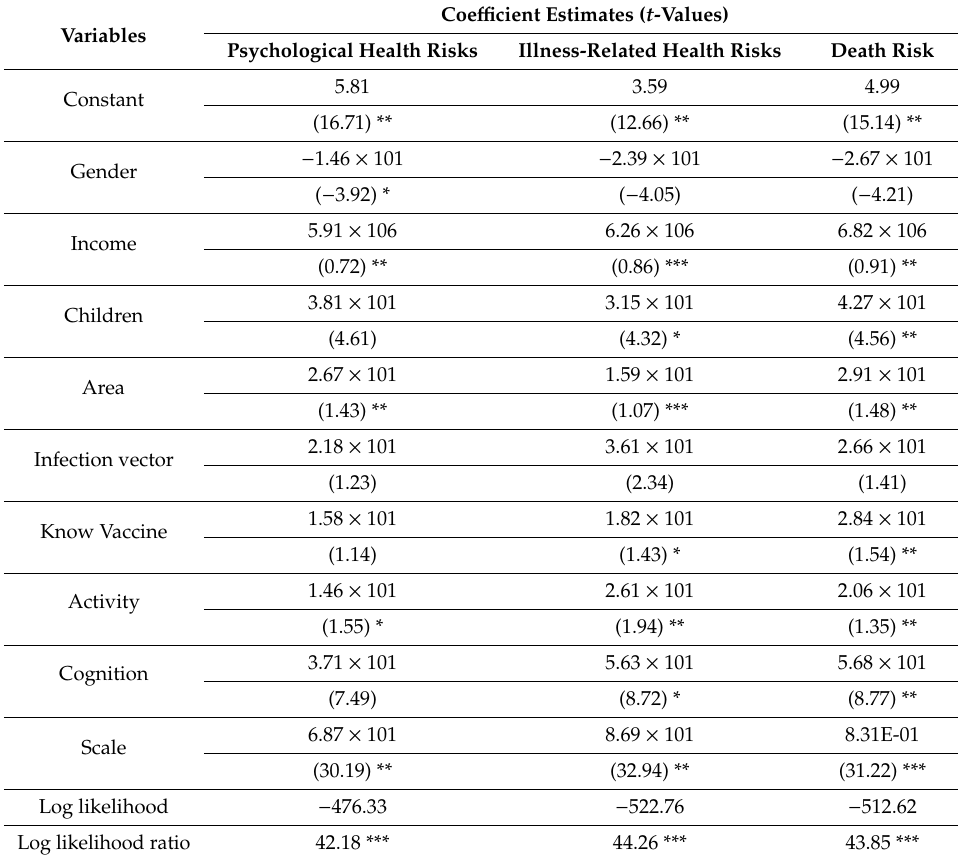
Table 5. Function estimation results for health risks and willingness to pay (WTP) for dengue prevention (Weibull